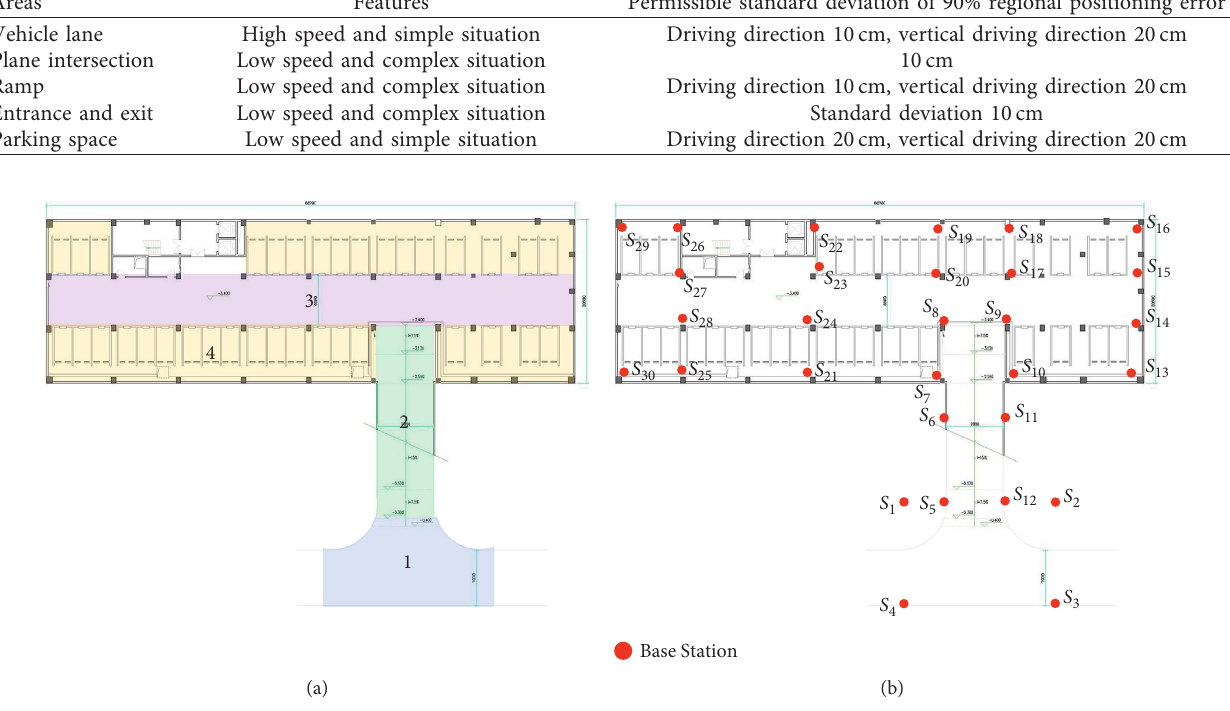
Figure 7: Schematic map of areas and adjusted UWB BS layout scheme.